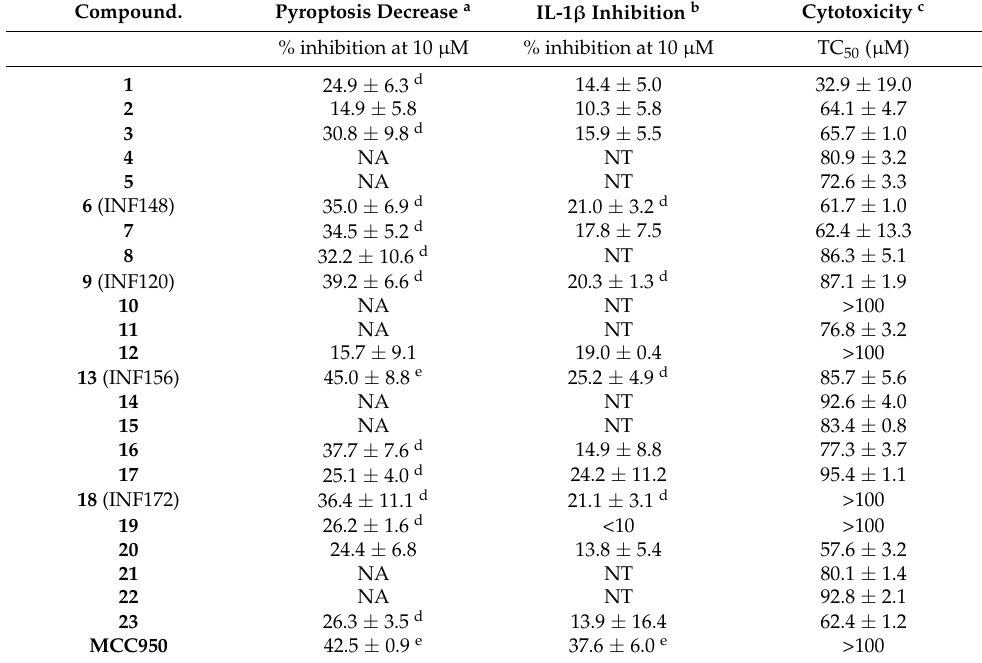
Table 1. Inhibitory effect of synthesised compounds on pyroptotic cell death, IL-1 β release in differentiated THP-1 cells and cytotoxicity in THP-1 cells. Compound. Pyroptosis Decrease a IL-1 β Inhibition b Cytotoxicity c % inhibition at 10 µ M % inhibition at 10 µ